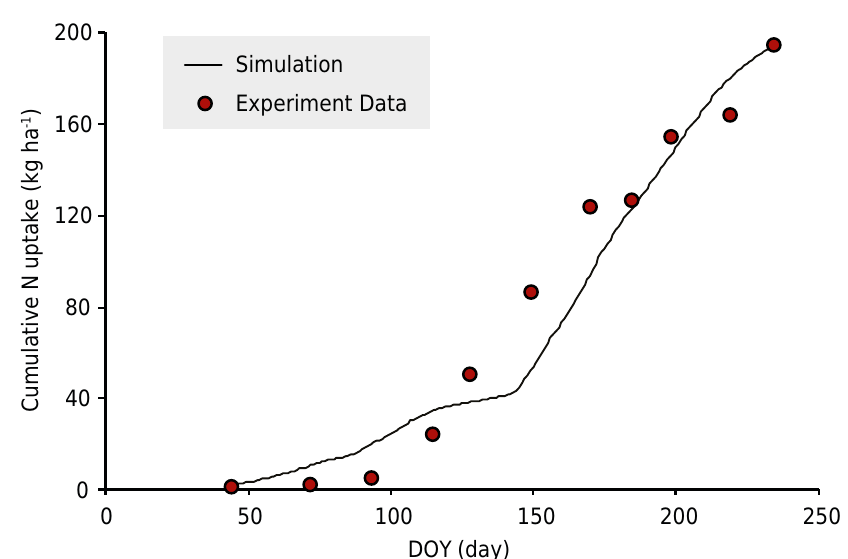
Figure 9. Comparison of cumulative nitrogen uptake by plant with time between measurement and simulation.